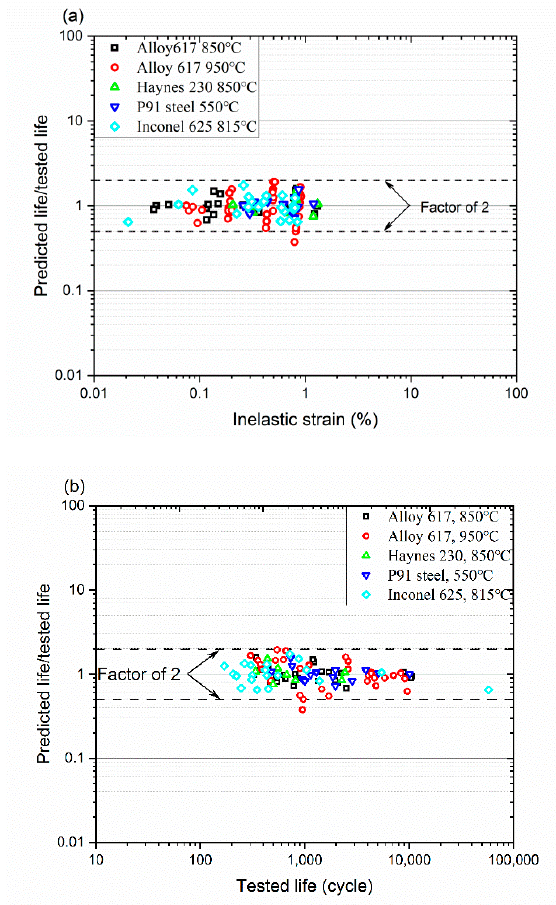
Figure 7. Predicted life/tested life versus ( a ) inelastic strain and ( b ) tested life.